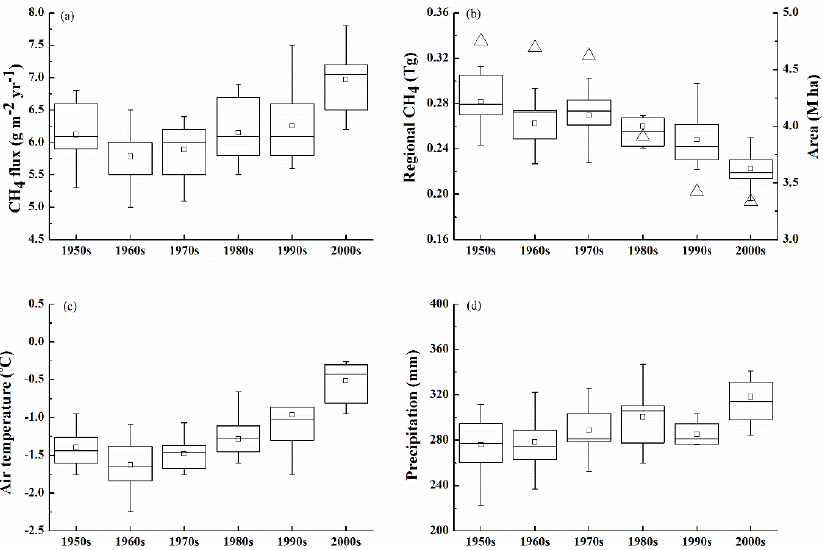
Figure 4. Temporal variations of ( a ) simulated decadal mean CH 4 fluxes, ( b ) decadal mean wetland area and regional CH 4 , ( c ) decadal mean air temperature, ( d ) decadal mean precipitation. Boxplots show the median, average values, and interquartile range, with whiskers extending to the most extreme data point within 1.5 × (75% – 25%) data range. Triangles represent the decadal mean wetland area.